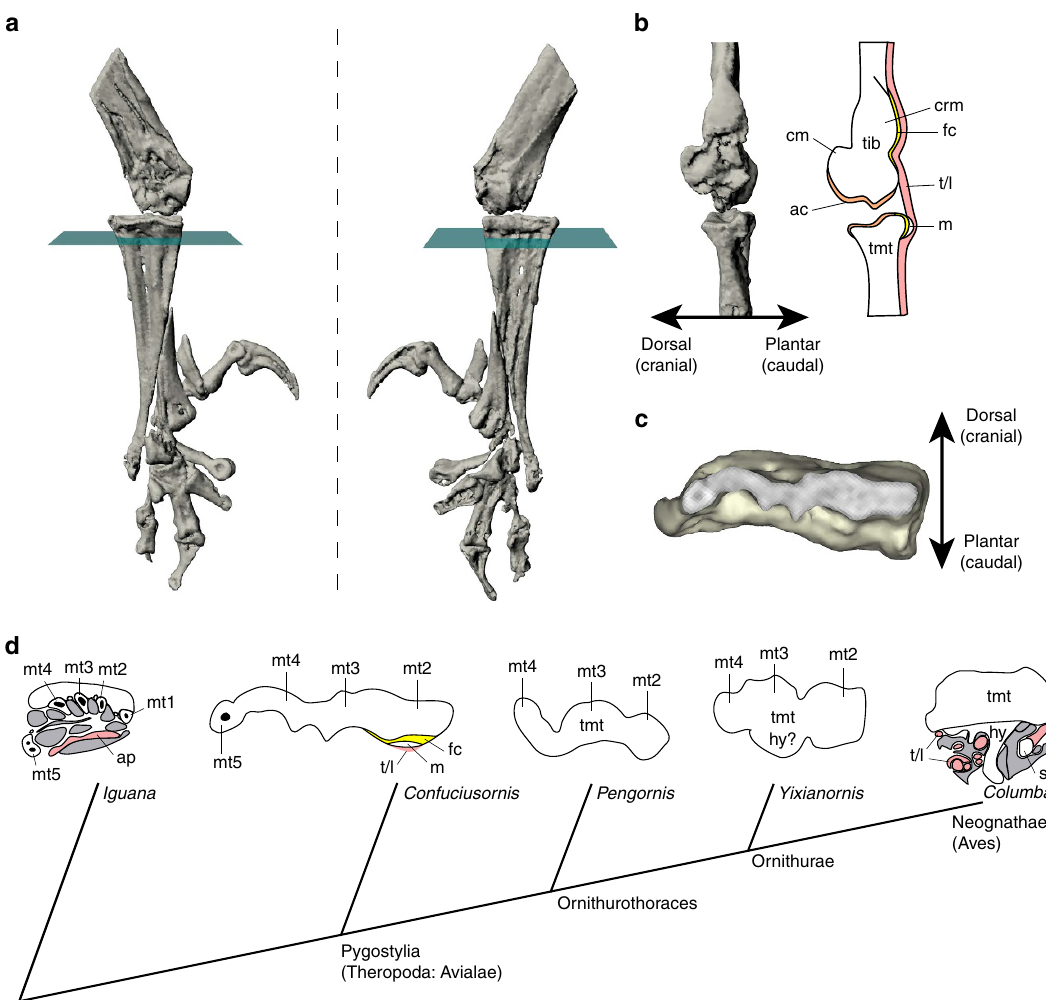
Figure 5 | Evolution of ankle anatomy in early birds. ( a ) Dorsal/cranial (left) and plantar/caudal (right) views of the right pes (and, more obliquely and proximally, the tibia) of Confuciusornis using scan data from Fig. 1, showing where virtual sections (blue-green planes perpendicular to bones) were taken for use in b – d . ( b ) Inferred distribution of the preserved tendons/ligaments, fibrocartilages, articular cartilages, cartilaginous cristae and ridges in the right ankle joint of Confuciusornis . Medial view emphasizing the wrap-around tendons of the digital flexors, associated fibrocartilage and mineralization. ( c ) Cross-sectional reconstructed scan data from the proximal tarsometatarsus as shown in a and used in d . ( d ) Drawing of histological horizontal cross-sections through the proximal end of the tarsometatarsus (or metatarsus) of squamate Iguana 38 , pygostylian bird Confuciusornis , enantiornithine bird Pengornis , ornithuran bird Yixianornis and crown-group bird Columba 39 shows our hypothesis for the evolution of the hypotarsus (hy) and other derived features of avian ankles. Pink colours are tendinous/ligamentous tissue; white is bone; grey is muscular tissue and yellow is (fossilized) fibrocartilage. From left to right, as the number of main toes was reduced and the pes narrowed and consolidated, becoming more robust, it became more plantarly projected (that is, a larger hypotarsus) and formed fibrocartilages, mineralizations and ultimately bony ridges and grooves to enhance the leverage of as well as enclose and guide the pedal tendons. See Figs 1 and 2 for abbreviations. Not to scale. Virtual ‘histological’ sections for the simple sketches of Pengornis (IVPP V15336) and Yixianornis (IVPP V12558) were done digitally using microCTscan data from ref. 3, at the approximate same proximodistal position as the other images, following the procedure shown in a and c